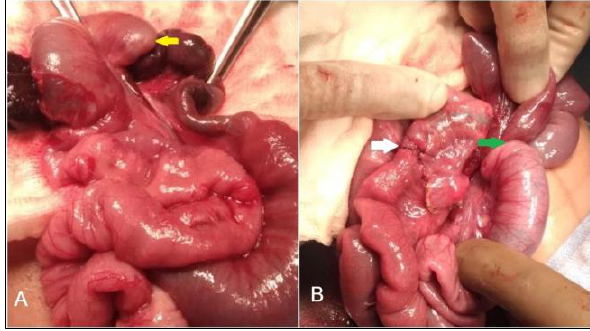
Figure 1: A) Ileocolic intussusception (yellow arrow). B) Jejunojejunal intussusception (green arrow) with distal anastomosis (white arrow).